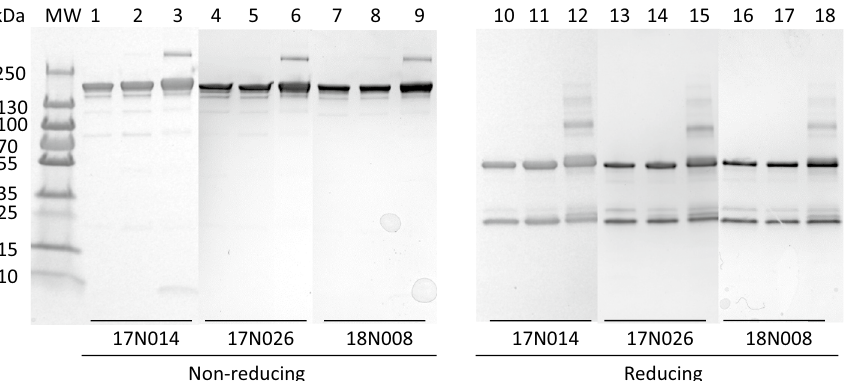
Fig. 2 A SDS-PAGE analysis under non-reducing conditions of trastuzumab (lanes 1,4,7), BnDTPA-trastuzumab (lanes 2,5,8) and BnDTPA-trastuzumab-NLS in kit lots 17N014, 17N026 and 18N008 (lanes 3, 6, 9). B. SDS-PAGE analysis under reducing conditions (DTT) of trastuzumab (lanes 10,13,16), BnDTPA-trastuzumab (lanes 11,14,15) and BnDTPA-trastuzumab-NLS in kit lots 17N014, 17N026 and 18N008 (lanes 12, 15,18). The gel was stained with Coomassie R-250 Brilliant Blue. MW: broad range molecular weight standards